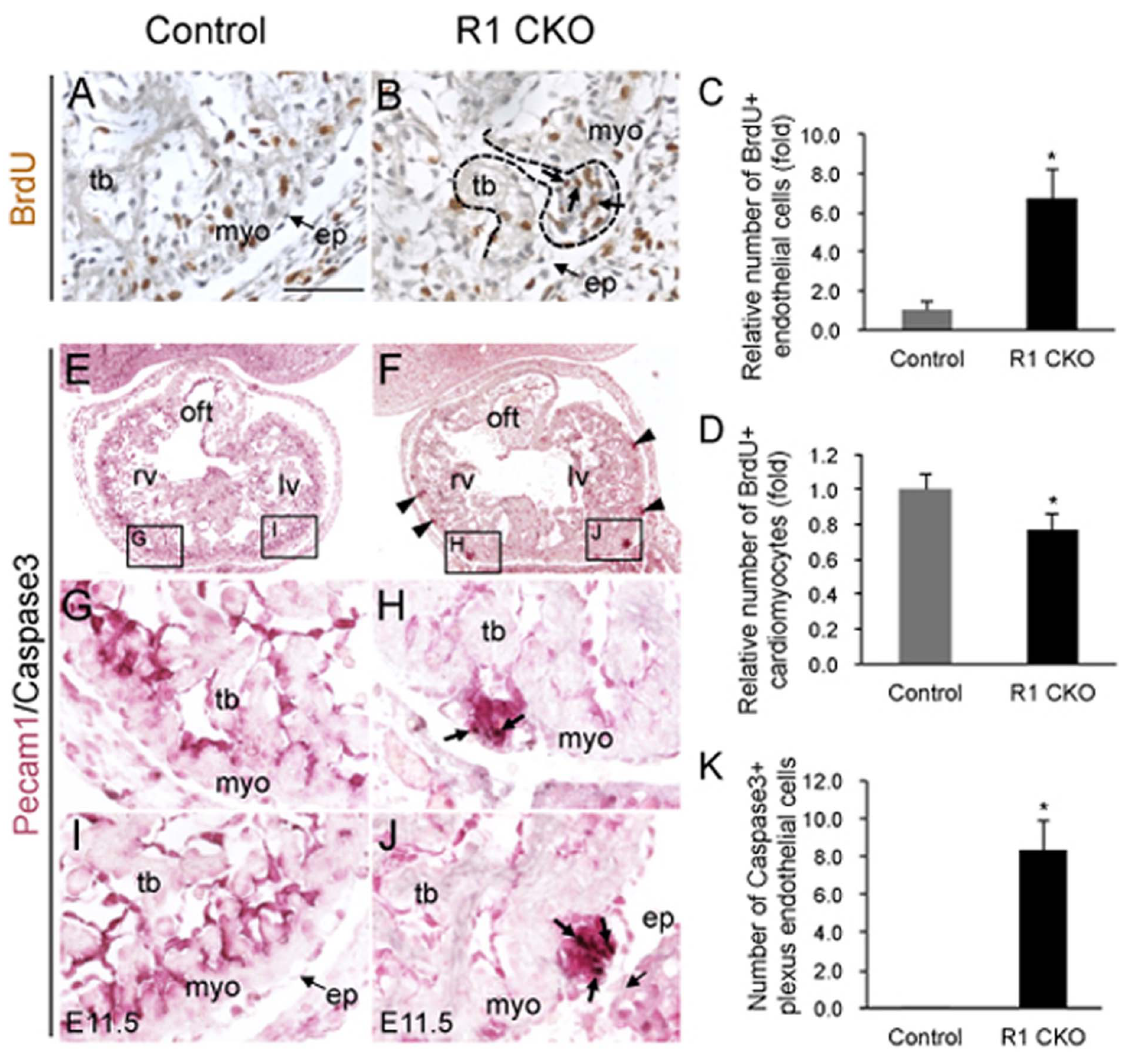
Figure 3. The coronary plexuses in the R1 CKO hearts are unstable and self-limited through apoptosis. A, B, Images of E11.5 ventricle immunostained with antibodies against BrdU (brown nuclear staining) showing the proliferating plexus endothelial cells in the R1 CKO hearts ( B , indicated by arrows and dash line). No plexus is present in the same region of the control heart ( G ). Scale bar =50 m m. C, D, Statistical analyses showing a significantly increased proliferation of the plexus endothelial cells ( C ) and decreased proliferation of cardiomyocytes ( D ) in the E11.5 R1 CKO hearts. n =3 individual hearts, 5 comparable sections per heart, error bars=SD. E-J, Images of the frontal sections of E11.5 ventricles co- immunostained with the antibodies against Pecam1 (purple membrane staining) and Caspase3 (black nuclear staining) showing the apoptotic endothelial cells within the overgrowing coronary plexuses in the R1 CKO embryos ( F , arrowheads; H and J , arrows). No apoptosis is present in the control hearts ( E , G , I ). K, Quantitative analysis showing a significantly increased apoptosis of the R1 CKO endothelial cells. n =3 individual hearts,